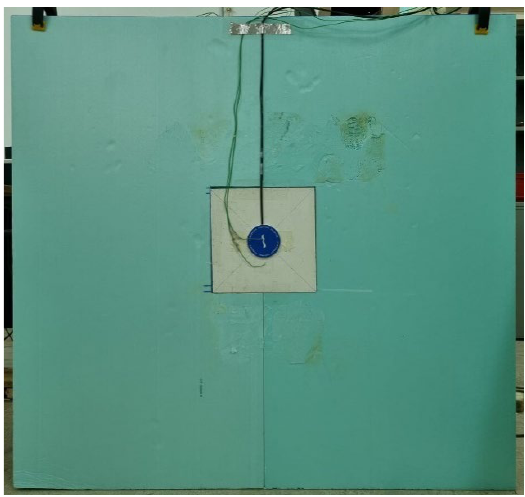
Figure 6. Sample placed in XPS frame.